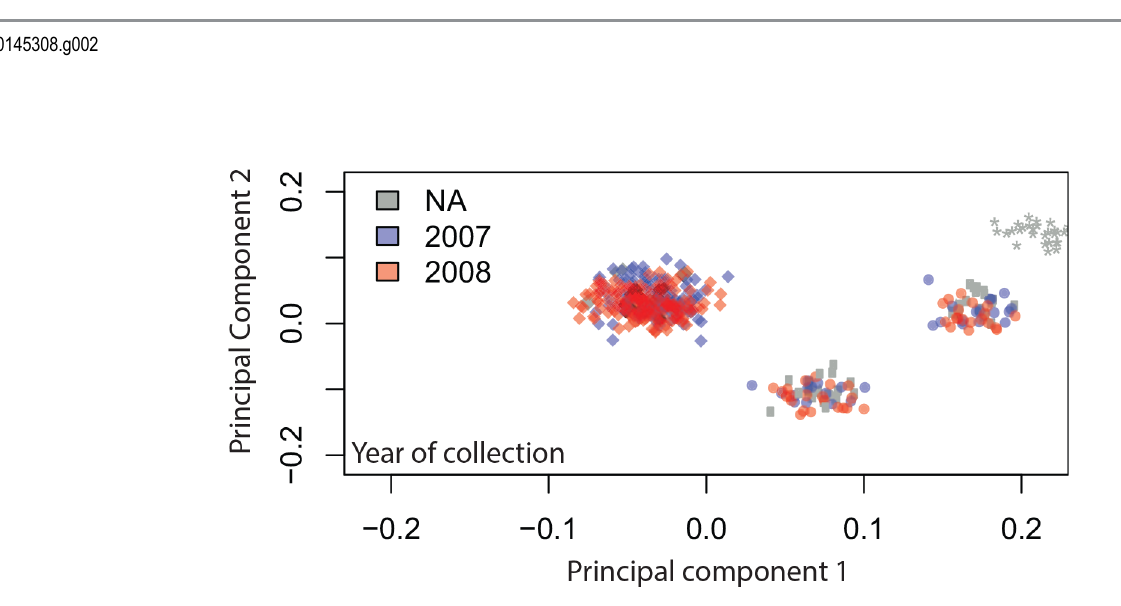
Fig 3. Population subdivision is comparable across two malaria transmission seasons. Samples are colored by collection year, 2007 (red) and 2008 (blue). The 96 pilot samples used for initial quality control are indicated in gray. There is no significant difference in the composition of the local mosquito population across years (chi-square = 0.457, df = 2, p = 0.796).